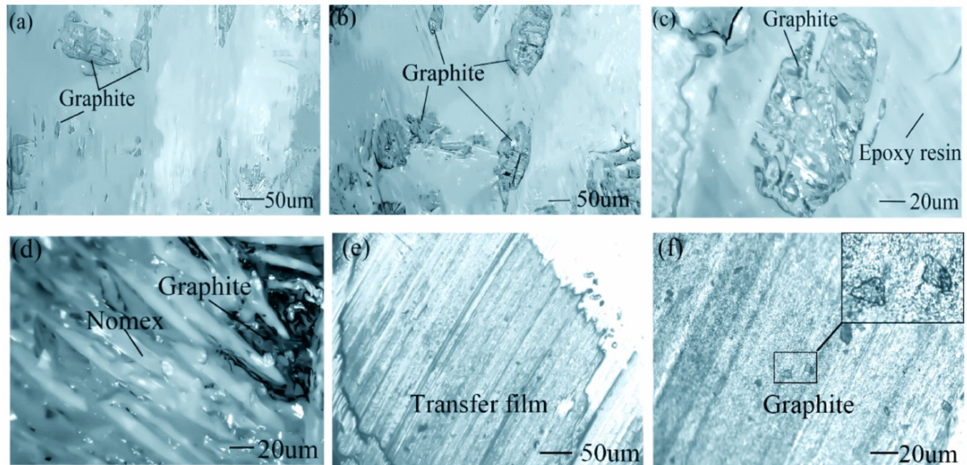
Figure 7. Graphite phase of the fabric laminate sample, ( a , b ) graphite embedded in the epoxy resin matrix, ( c ) an enlarged view of the graphite phase in ( b ) and ( d ) graphite embedded in Nomex fibers. ( e ) The transfer film on the pin and ( f ) the enlarge view of ( e